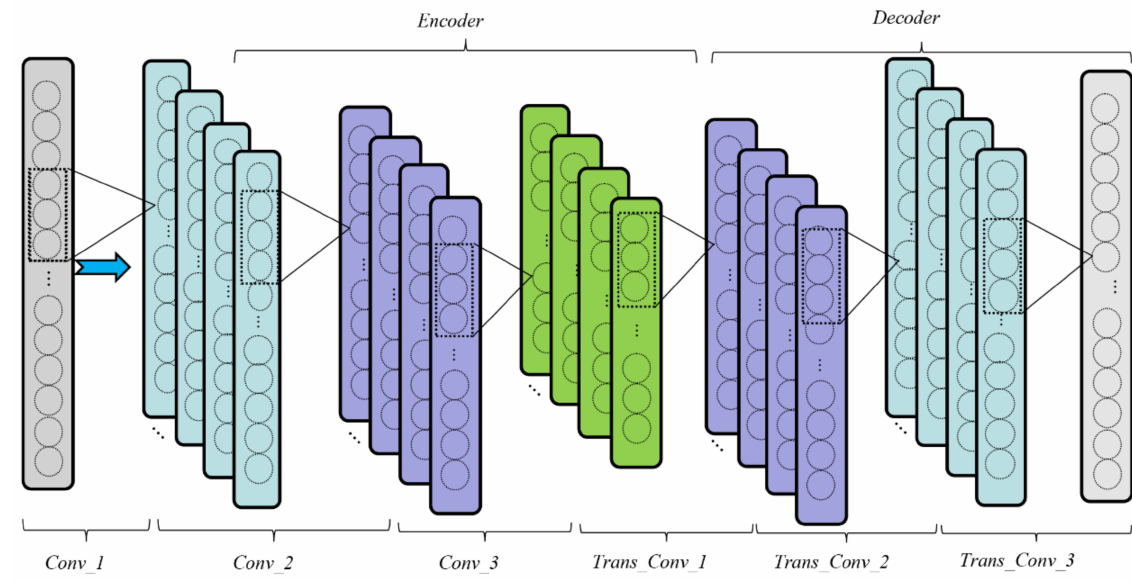
Figure 5. The structure of a